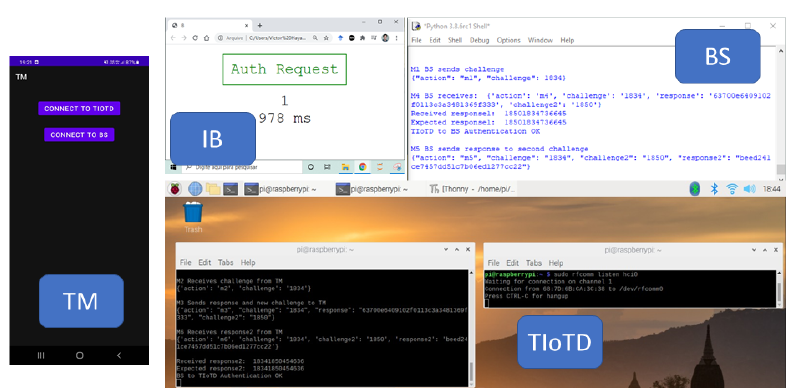
Figure 11. Proposed protocol with